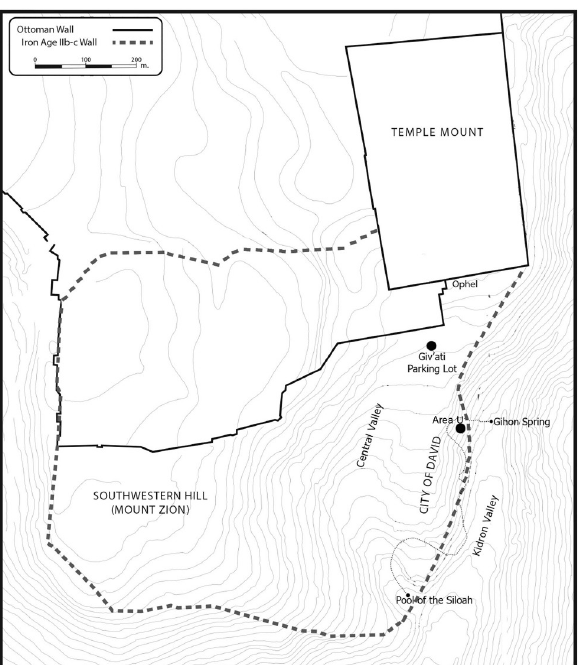
Fig 1. Map showing the location of the two excavation area on the "City of David" ridge in Jerusalem. Produced by Nitsan Shalom, the City of David expedition.